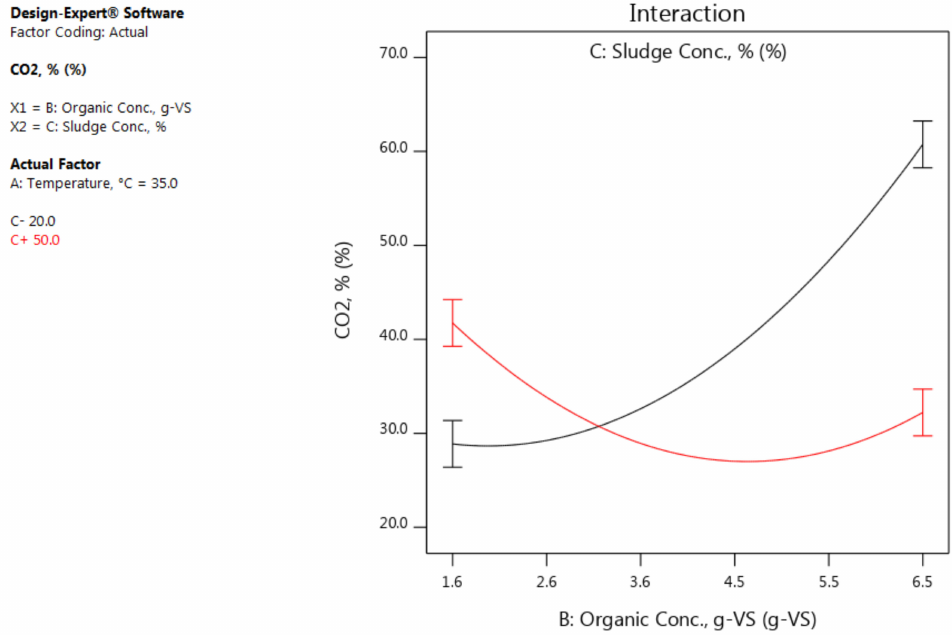
Figure 9. An interaction plot illustrating the influence of (BC) on the CO 2 %.